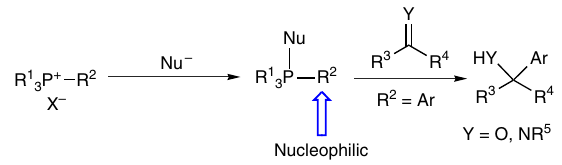
Figure 1 | Design of arylation reaction with phosphonium salt. An aryl substituent on phosphorus can act as a nucleophile to realize the nucleophilic arylation of carbonyls and imines.